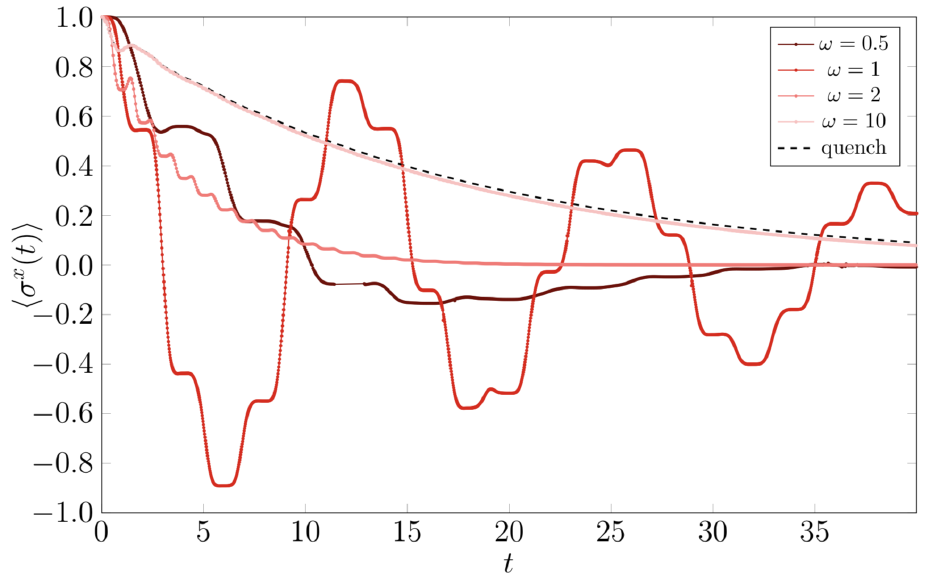
Figure 4: Order parameter expectation value 〈 σ x ( t ) 〉 as a function of t , with the variation of magnetic field h ( t ) = 1 evolution after a sudden quench h ( t ) = 1